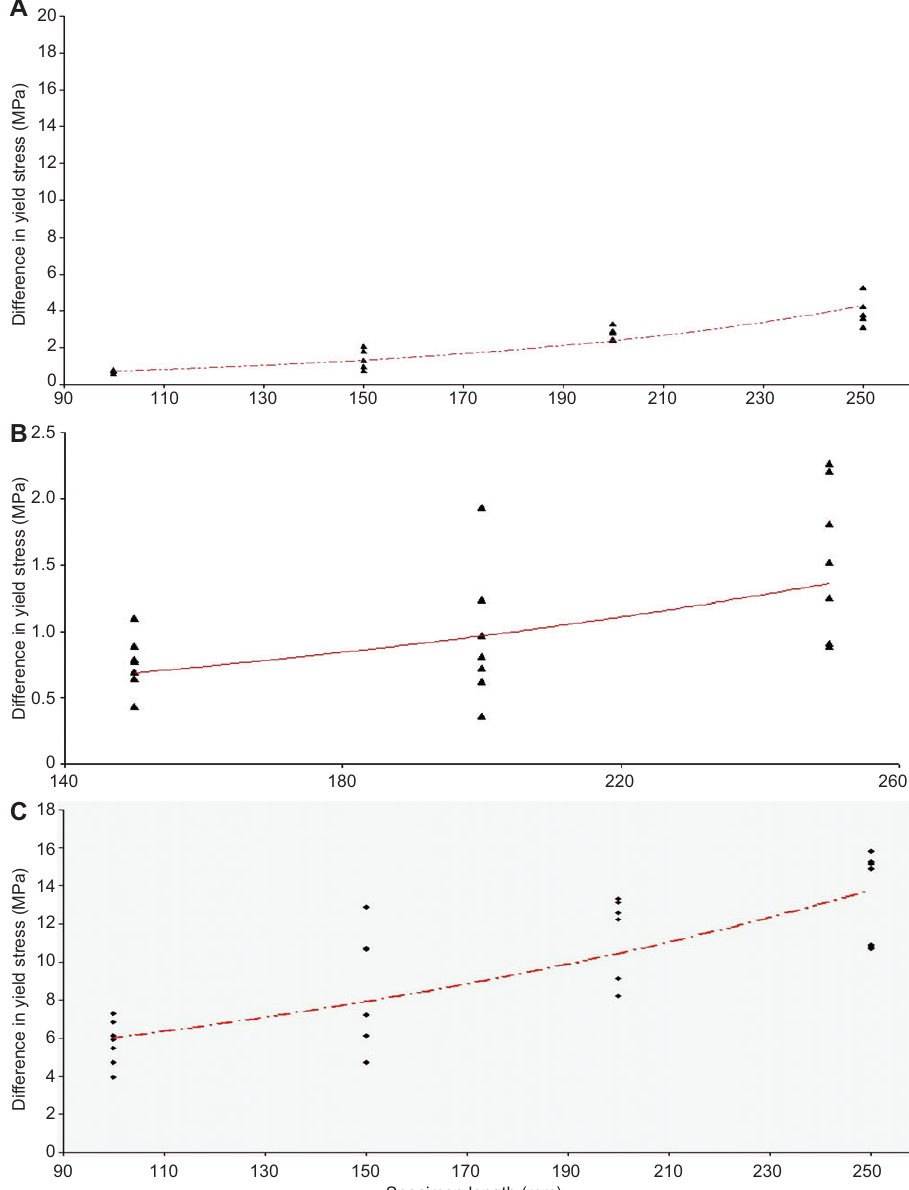
Figure 10 Effect of specimen length on the difference in yield stress for (A) 1 mm, (B) 2 mm and (C) 3 mm diameter NiTi shape memory alloys wire.